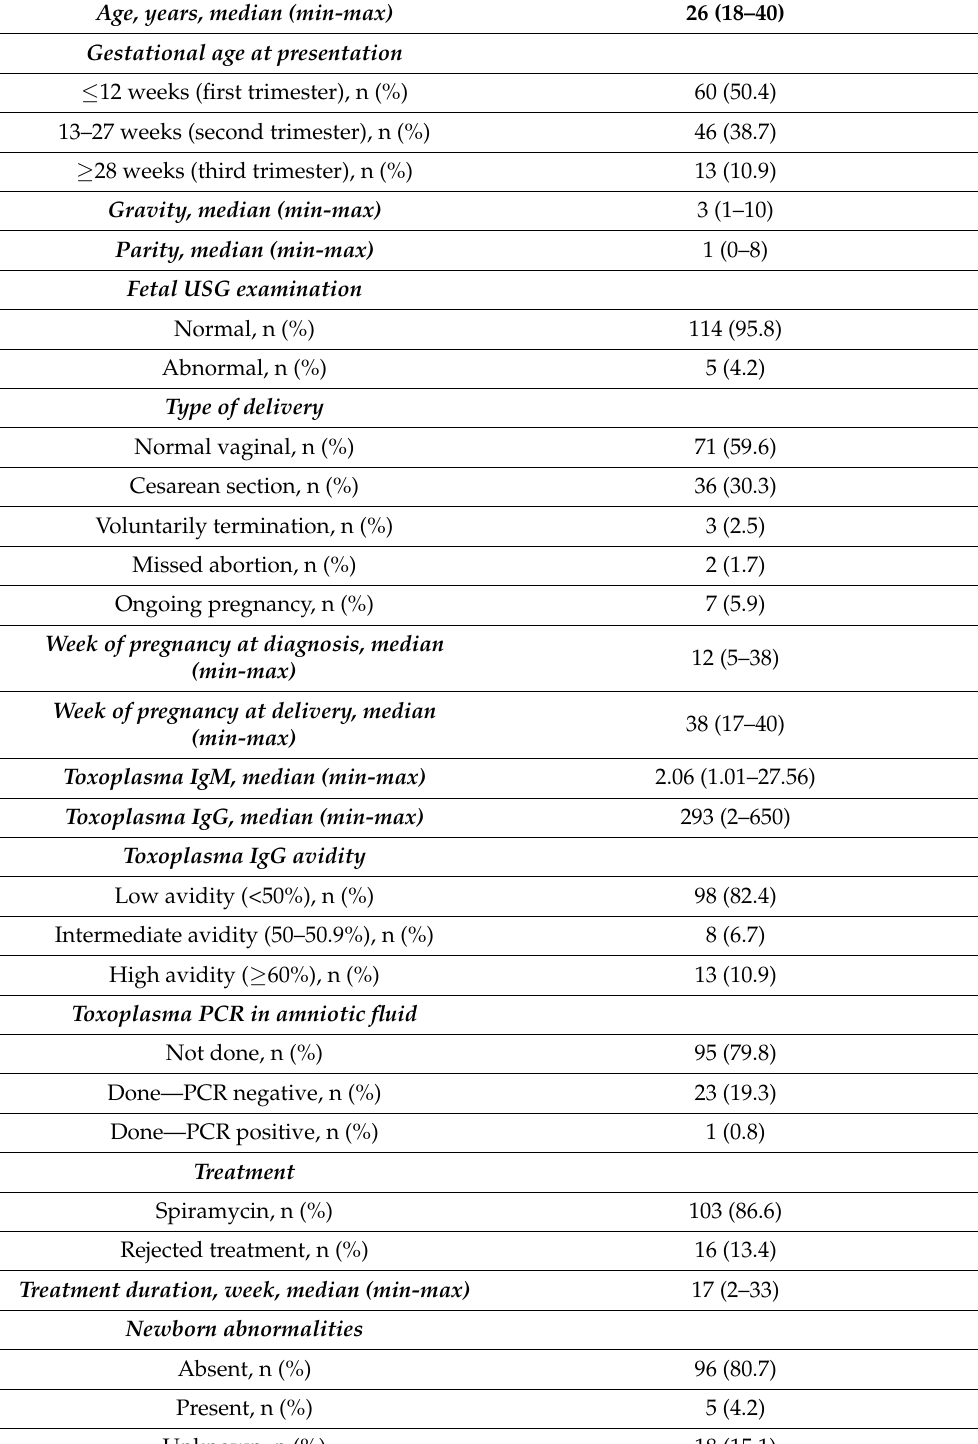
Table 1. Maternal characteristics and outcomes of acute toxoplasma infection in pregnant